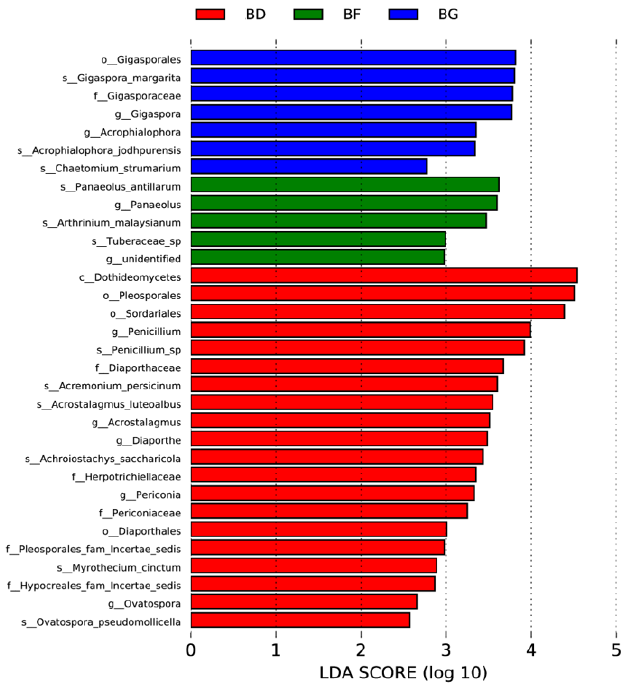
Figure A2. The indicator fungi with LDA scores > 2 in fungal communities were associated with different biochar–organic fertilizer treatments.